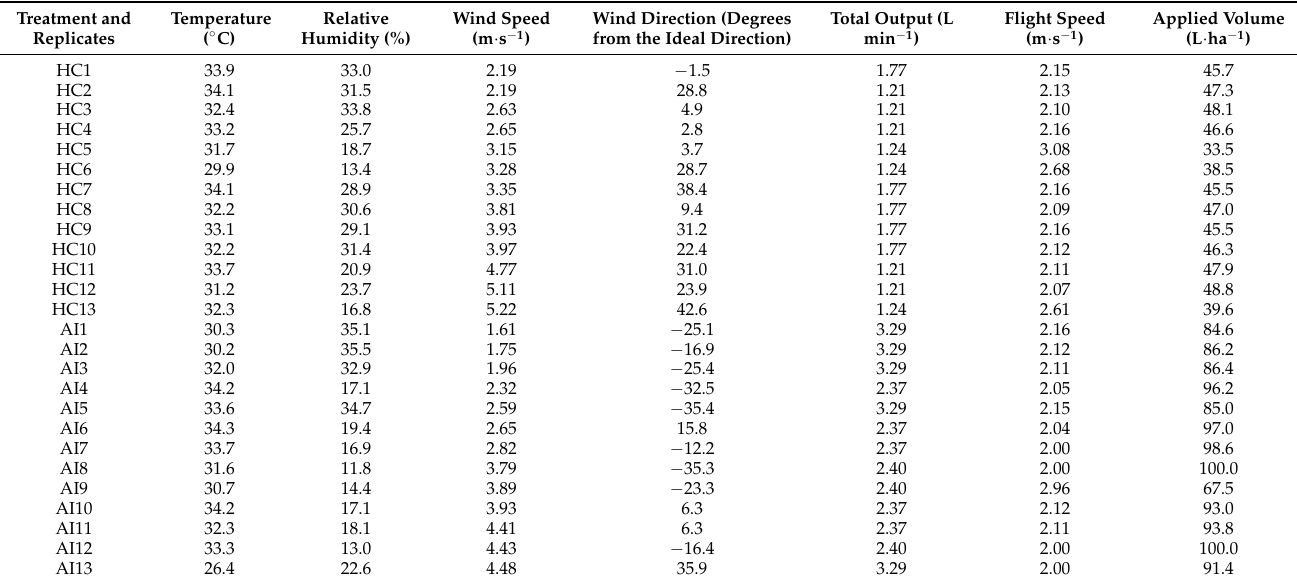
Table 1. Meteorological conditions and experimental parameters of all spray drift